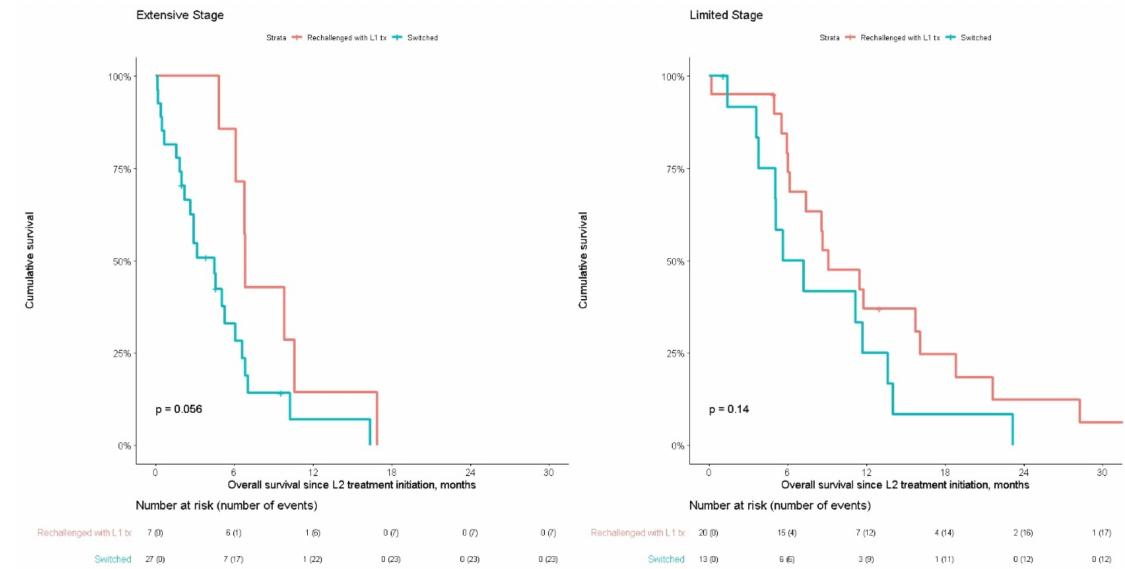
Figure 2. Overall survival from L2 treatment initiation for patients sensitive to L1 therapy (initiated L2 ≥ 3 months after cessation of L1 therapy), for re-challenge of L1 therapy or switch, split by extensive (n = 34) and limited (n = 33)